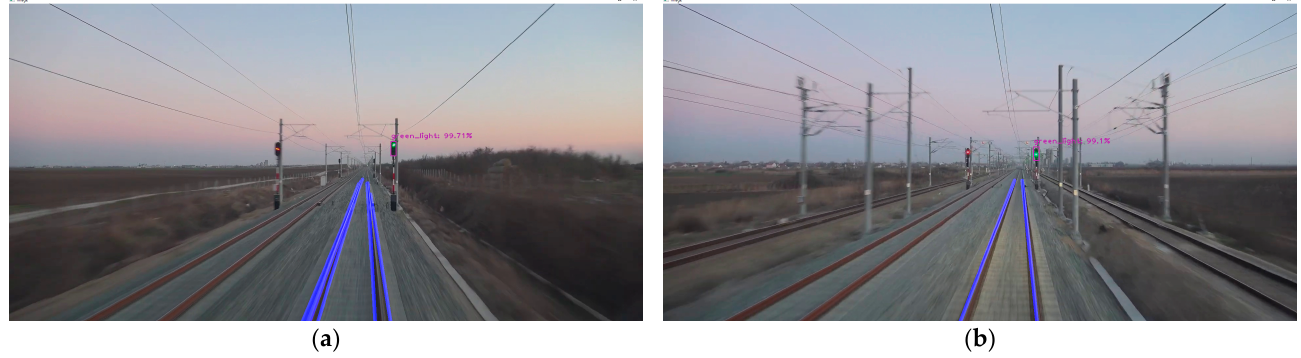
Figure 15. System for detection of rail track and signals on the railway based on integrated Hough– YOLO method ( a ) Signal relatively close from the camera; ( b ) signal relatively far to the camera..